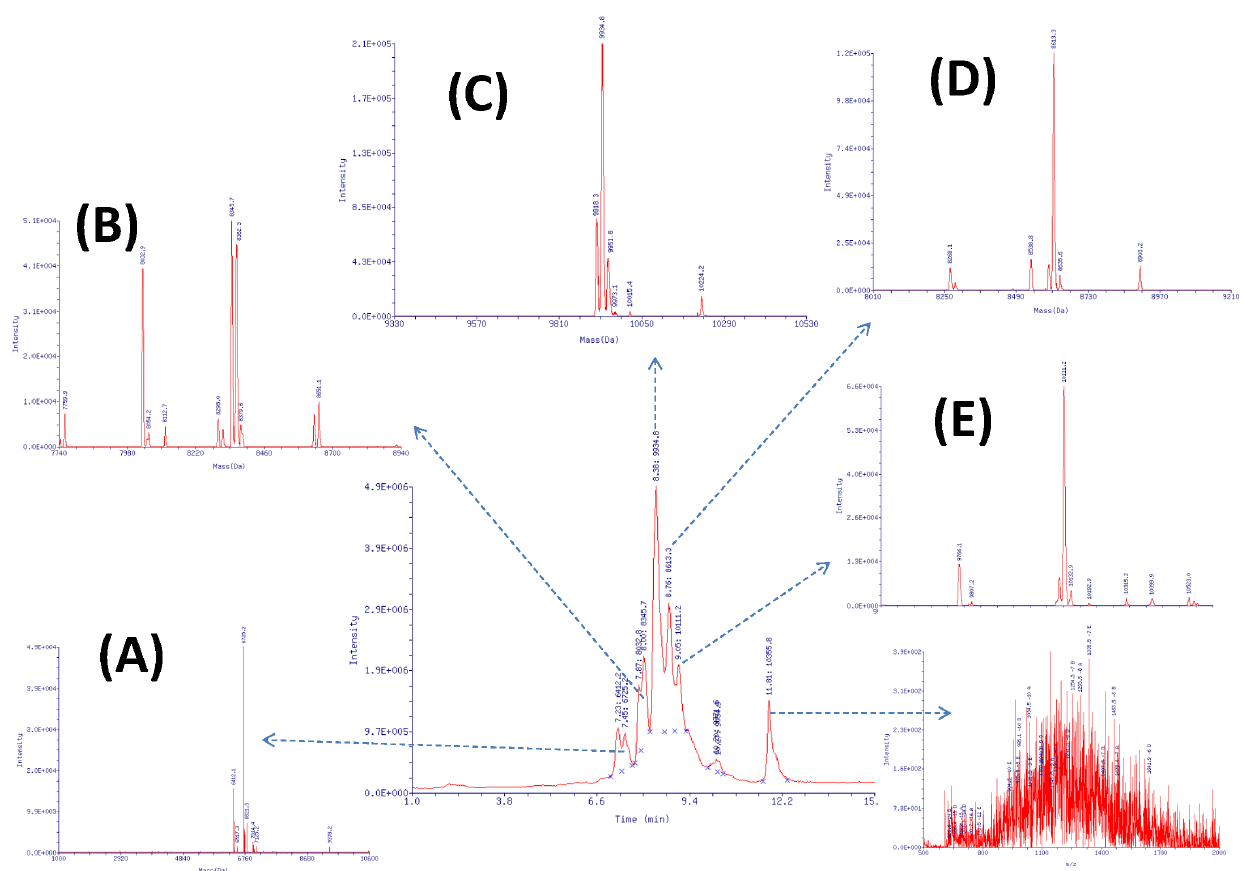
Figure 4. The LC/UV Chromatogram and Deconvoluted Mass Spectrum of the *A*G PEAR product. Components: (A) RT=7.45 min: MW=6742.0; (B) RT=8.00 min; (C) RT=8.38 min; (D) RT=8.76 min; (E) RT=9.05 min; See Table S2 in File S1 for detailed characterization of components.